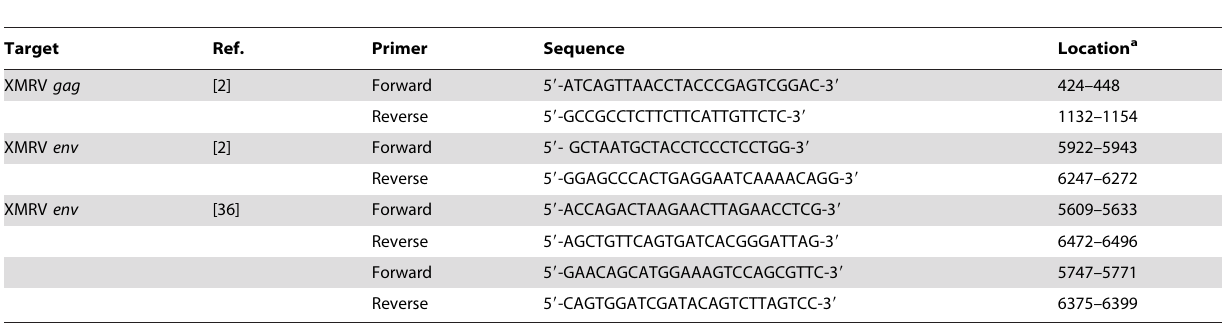
Table 1. Primers used for screening PBMC DNA specimens for XMRV.